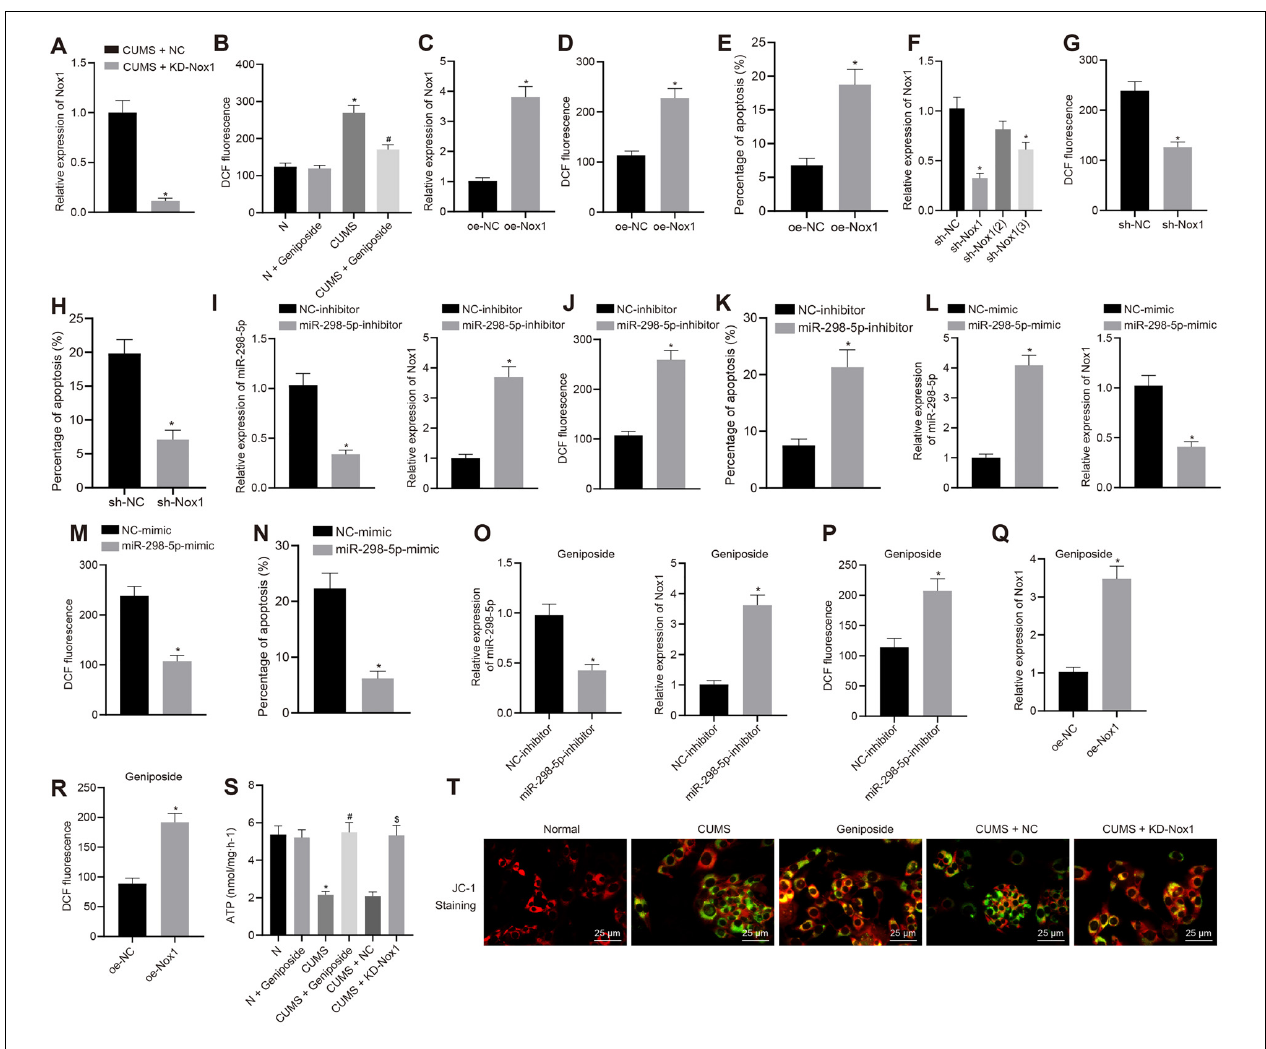
FIGURE 2 | Geniposide reduced reactive oxygen species (ROS) content, inhibited oxidative stress and protected mitochondrial function in neurons by reducing Nox1 expression. (A) The Nox1 mRNA expression in the mouse frontal cortex determined by RT-qPCR ( n = 10). * p < 0.05 vs. CUMS mice treated with NC. (B) The ROS content in the frontal cortex neurons of normal mice, CUMS mice, and geniposide -treated CUMS mice ( n = 10). The variance analysis: F (3,36) = 274.1, p < 0.001. ∗ p < 0.05 vs. normal mice. # p < 0.05 vs. CUMS mice. (C) The Nox1 mRNA expression of neurons transfected with oe-Nox1 or oe-NC determined by RT-qPCR. (D) The ROS content of neurons transfected with oe-Nox1 or oe-NC. (E) The apoptosis level of neurons transfected with oe-Nox1 or oe-NC detected by flow cytometry. ∗ p < 0.05 vs. neurons transfected with oe-NC. (F) The Nox1 mRNA expression in neurons transfected with sh-Nox1 or sh-NC determined by RT-qPCR and the transfection efficiency of different shRNAs. The variance analysis: F (3,35) = 39.68, p < 0.001. ∗ p < 0.05 vs. neurons transfected with oe-NC. (G) The content of ROS in neurons transfected with sh-Nox1 or sh-NC. (H) The apoptosis level of neurons transfected with sh-Nox1 or sh-NC determined by flow cytometry. ∗ p < 0.05 vs. neurons transfected with oe-NC. (I) miR-298-5p expression and Nox1 mRNA expression in neurons transfected with miR-298-5p-inhibitor or NC-inhibitor measured by RT-qPCR. (J) The ROS content in neurons transfected with miR-298-5p-inhibitor or NC-inhibitor. (K) The apoptosis level of the neurons transfected with miR-298-5p-inhibitor or NC-inhibitors detected by flow cytometry. ∗ p < 0.05 vs. neurons transfected with NC-inhibitor. (L) miR-298-5p expression and Nox1 mRNA expression in neurons transfected with miR-298-5p-mimic or NC-mimic measured by RT-qPCR. (M) The ROS content of the neurons transfected with miR-298-5p-mimic or NC-mimic detected by flow cytometry. (N) The apoptosis level of the neurons transfected with miR-298-5p-mimic or NC-mimic detected by flow cytometry. ∗ p < 0.05 vs. neurons transfected with NC-mimic. (O) miR-298-5p expression and Nox1 mRNA expression in neurons from geniposide -treated CUMS mice after transfection with miR-298-5p-inhibitor or NC-inhibitor determined by RT-qPCR. (P) The ROS content in the neurons from geniposide -treated CUMS mice after transfection with miR-298-5p-inhibitor or NC-inhibitor. ∗ p < 0.05 vs. neurons from geniposide -treated CUMS mice transfected with NC-inhibitor. (Q) The Nox1 mRNA expression in neurons from geniposide -treated CUMS mice after transfection with oe-Nox1 or oe-NC determined by RT-qPCR. (R) The ROS content in neurons from geniposide -treated CUMS mice after transfection with oe-Nox1 or oe-NC detected by flow cytometry. ∗ p < 0.05 vs. neurons from geniposide -treated CUMS mice transfected with oe-NC. (S) The ATP content in the neurons of different treatments. The variance analysis: F (5,12) = 47.55, p < 0.001. (T) MMP in the neurons with different treatments ( × 400). ∗ p < 0.05 vs. neurons from normal mice. # p < 0.05 vs. neurons from CUMS mice. $ p < 0.05 vs. neurons from CUMS mice treated with NC. Data were measurement data and expressed as the mean ± standard deviation. The unpaired t -test was used to analyze comparisons between two groups, and comparisons among multiple groups were analyzed by one-way ANOVA, followed by Tukey’s post hoc test. The experiment was repeated three times independently.